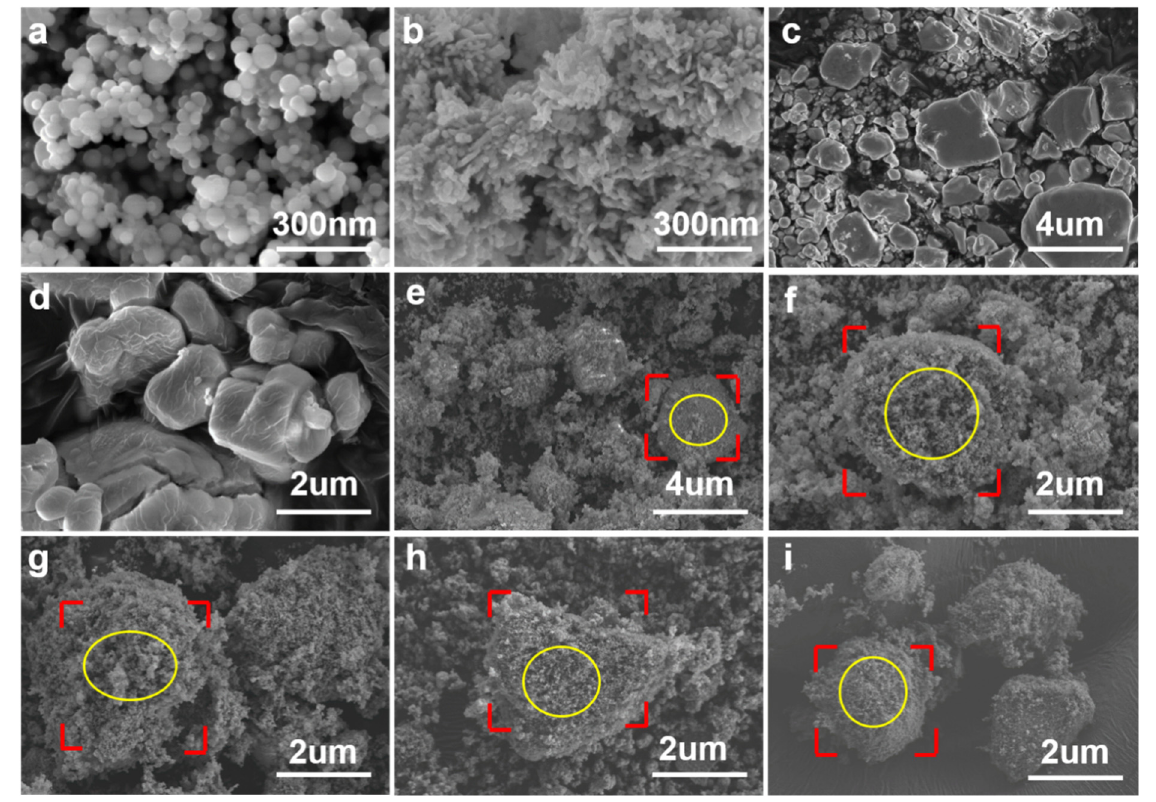
Figure 2. SEM images of samples: ( a ) Al, ( b ) CuO, ( c ) KIO 4 , ( d ) KClO 4 , ( e ) Al/CuO/30%KIO 4 , ( f ) Al/CuO/50%KIO 4 , ( g ) Al/KIO 4 , ( h ) Al/CuO/50%KClO 4 , ( i ) Al/KClO 4 .